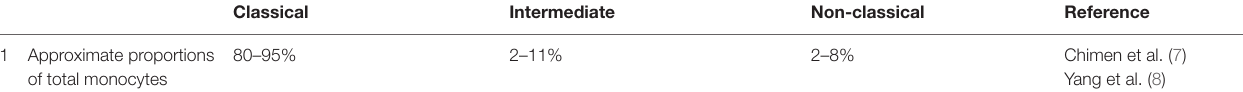
TABLe 1 | Phenotypic and functional differences of classical (CD14 ++ , CD16 − ), intermediate (CD14 ++ , CD16 + ), and non-classical monocyte (CD14 + , CD16 ++ )